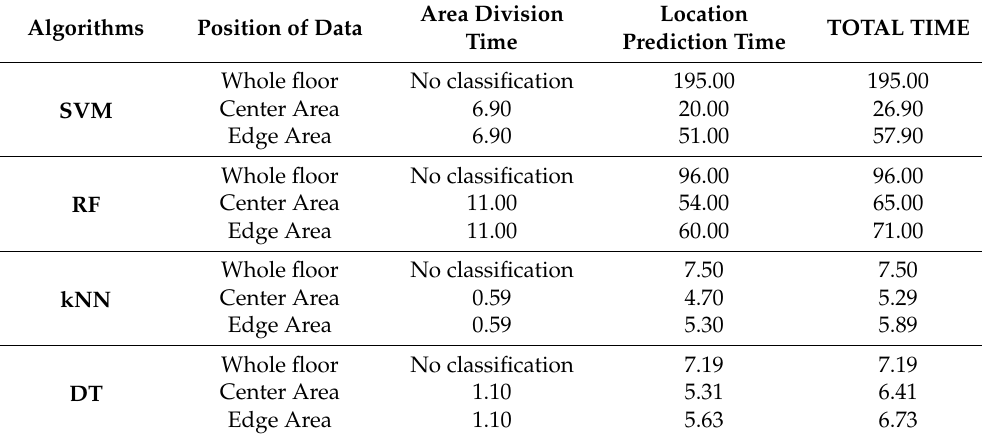
Figure 21. Computational time comparison before and after area division. Table 3. Computational time (ms).